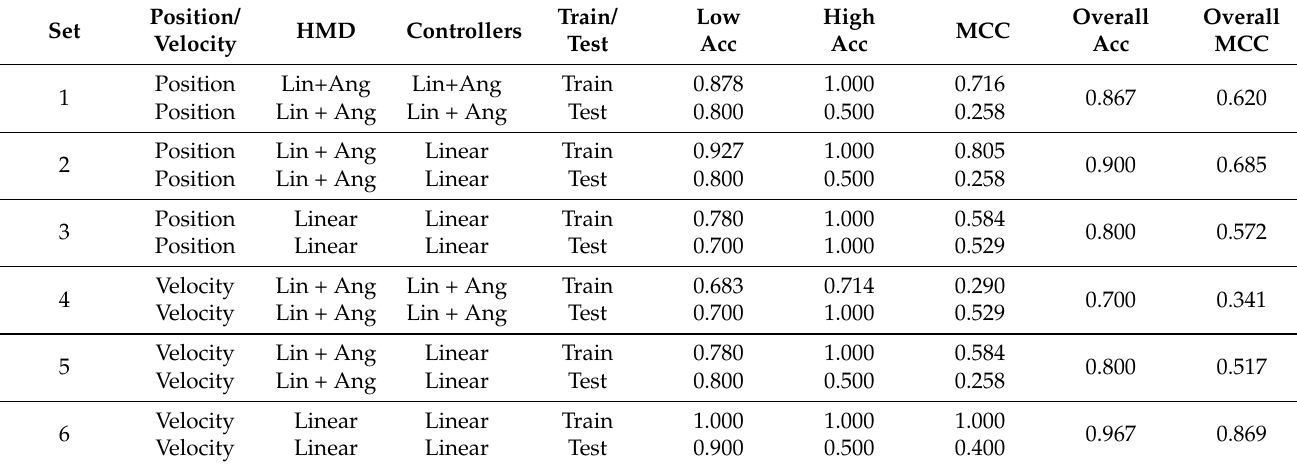
Table 7. Performance Retention prediction results. For each of the six sets of input features, the accuracy of the low- performance and high-performance predictions and the MCC are shown for both the training and testing data. Accuracy and MCC are also shown for each set of input features across the entire dataset (i.e., both the training and testing data).